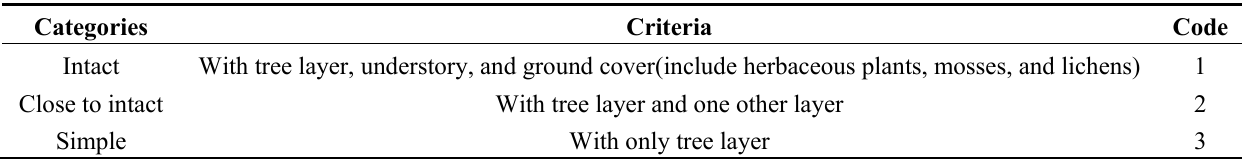
Table 5. Criteria for classifying the vertical structure of a forest stand to the different categories [20].